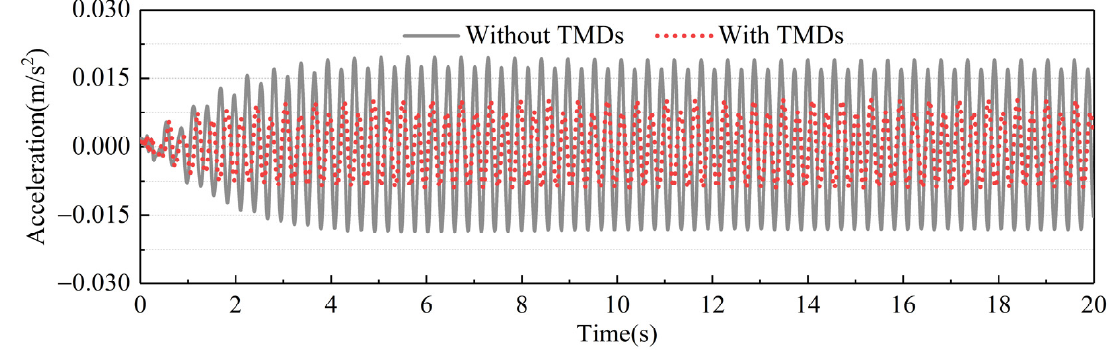
Figure 16. Acceleration time-history responses of the suspended floor with and without TMD under case WP-1.